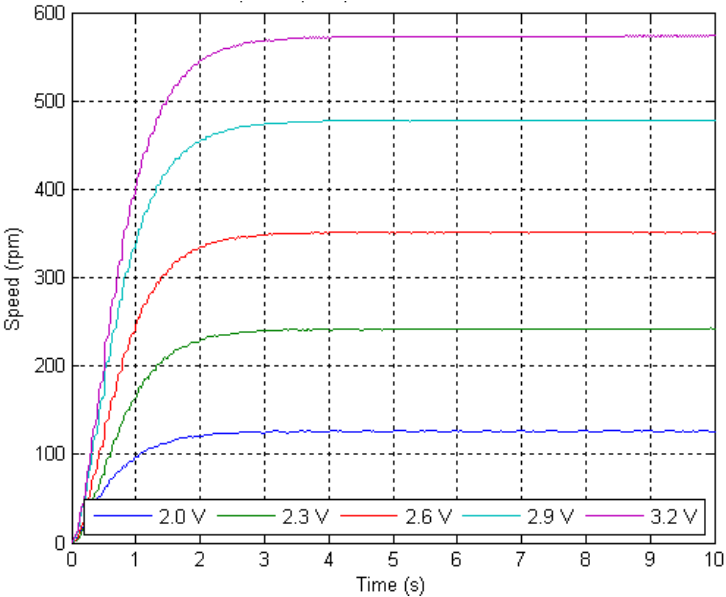
Figure 4. Open loop response of DC servo